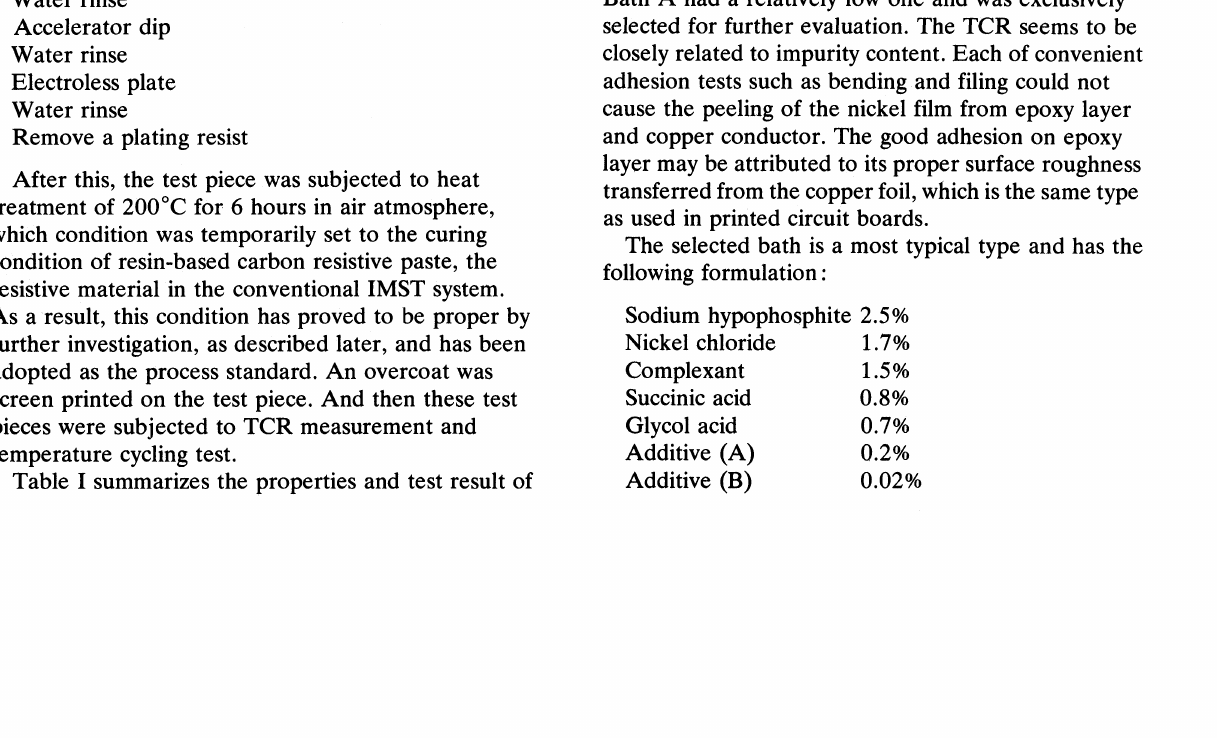
The structure and configuration of test piece using IMST